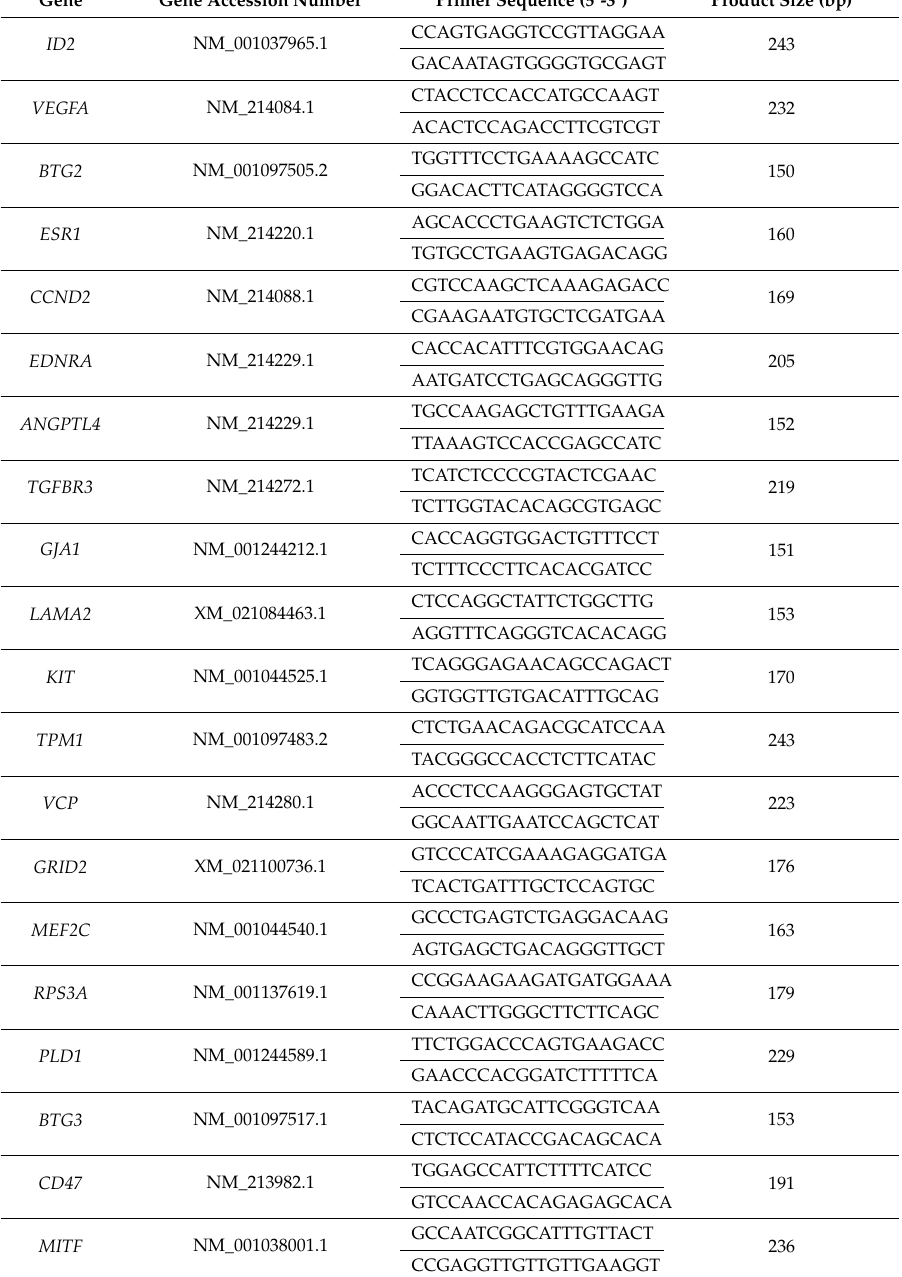
Table 3. Primers Oligonucleotide sequences of primers used for RT-qPCR